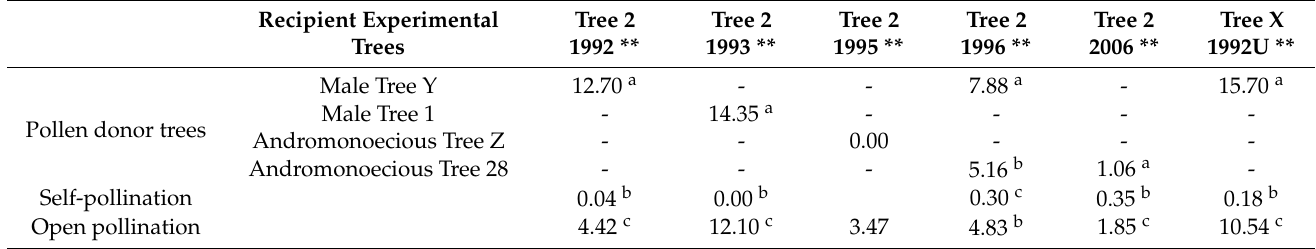
Table 2. Fruit set rates (%) in different pollination experiments in five different years ( χ 2 test;